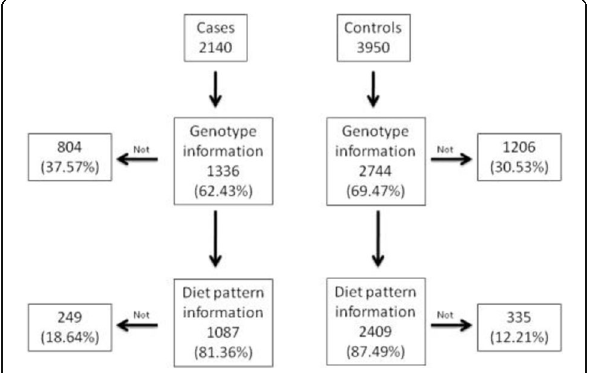
Fig. 2 Algorithm for cases and controls for this study, selected